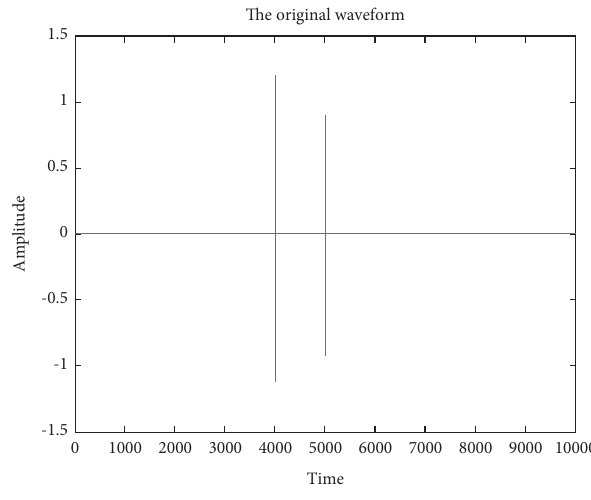
Figure 5: Detection waveform of the sample